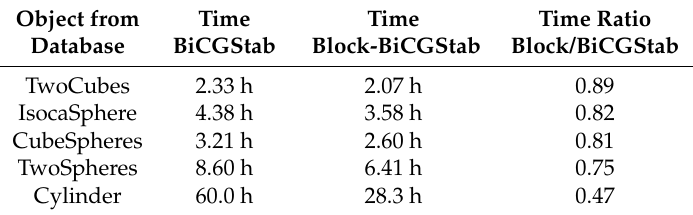
Table 4. Reconstruction time for the five objects of Fresnel database using BiCGStab and block-BiCGStab for linear system